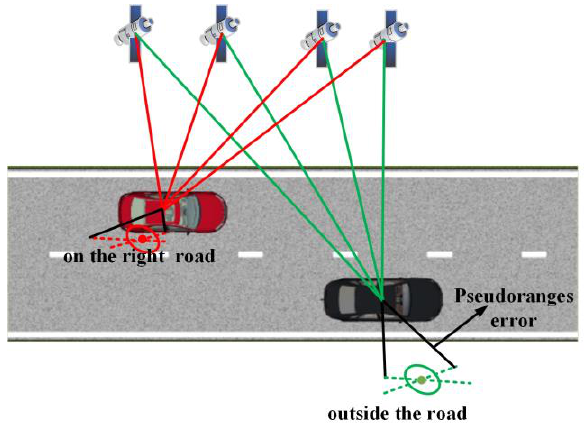
Figure 1. Illustration of biased localization caused by pseudoranges error.